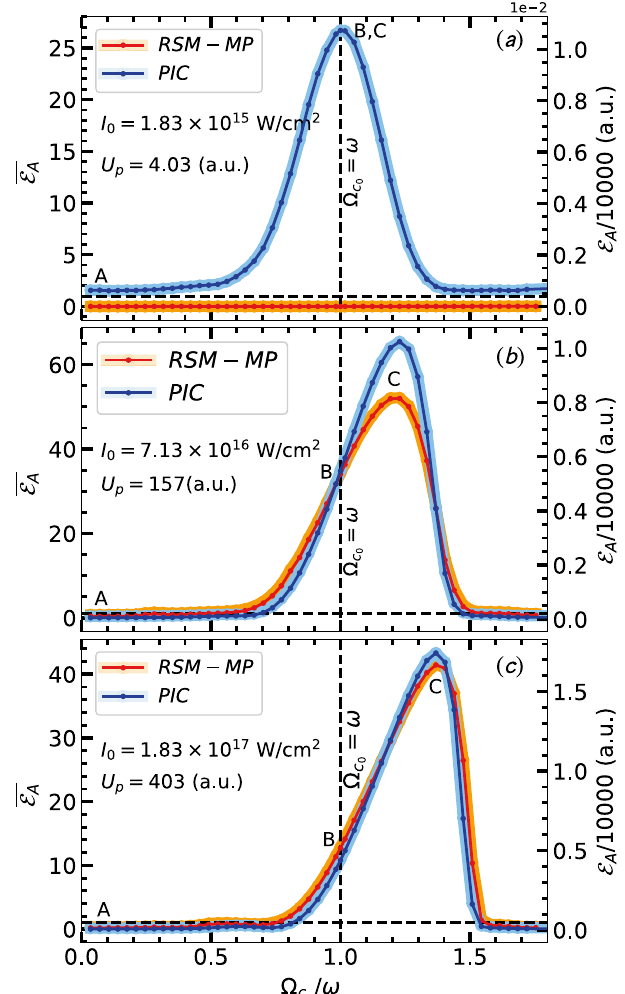
E (τ) per particle vs � c 0 /ω for a = 15 W/cm 2 1.83 10 17 W/cm 2 . − × ω (vertical dashed line) as clearly exhibited = � c 0 /γ for γ > 1 . = 0.27, 0.49 MeV ≈